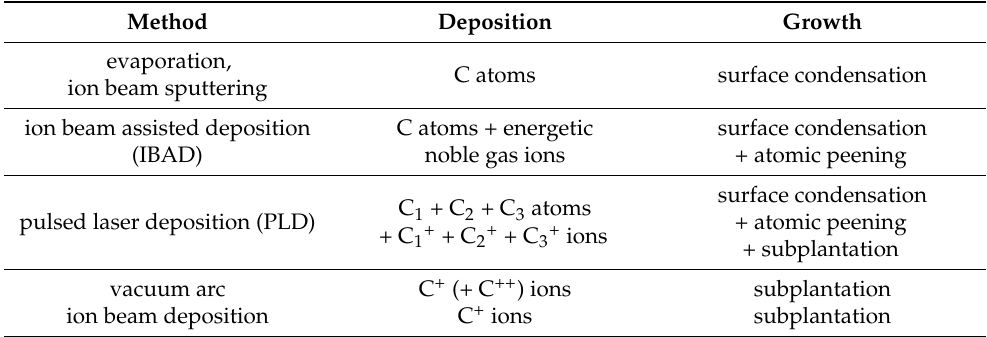
Table 2. Methods for the deposition of hydrogen-free carbon films (IBAD = ion beam